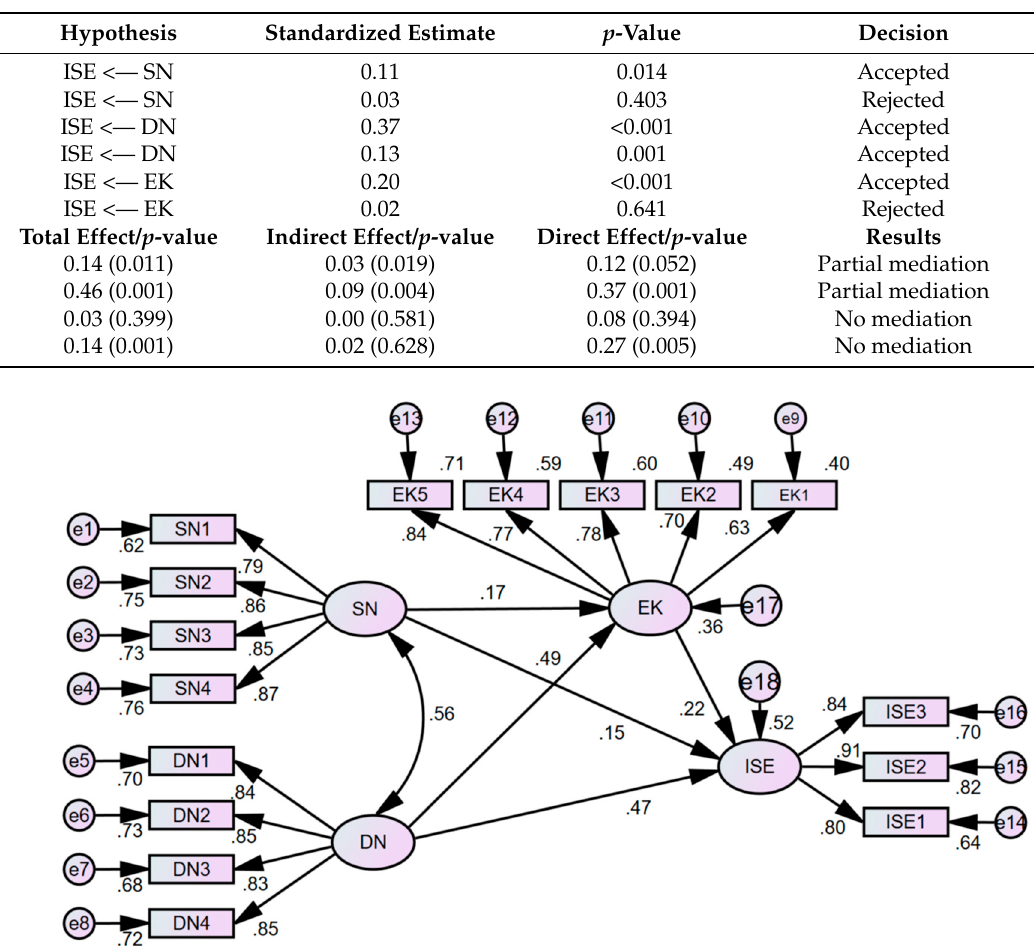
Table 4. Path Analysis and Hypotheses Test.